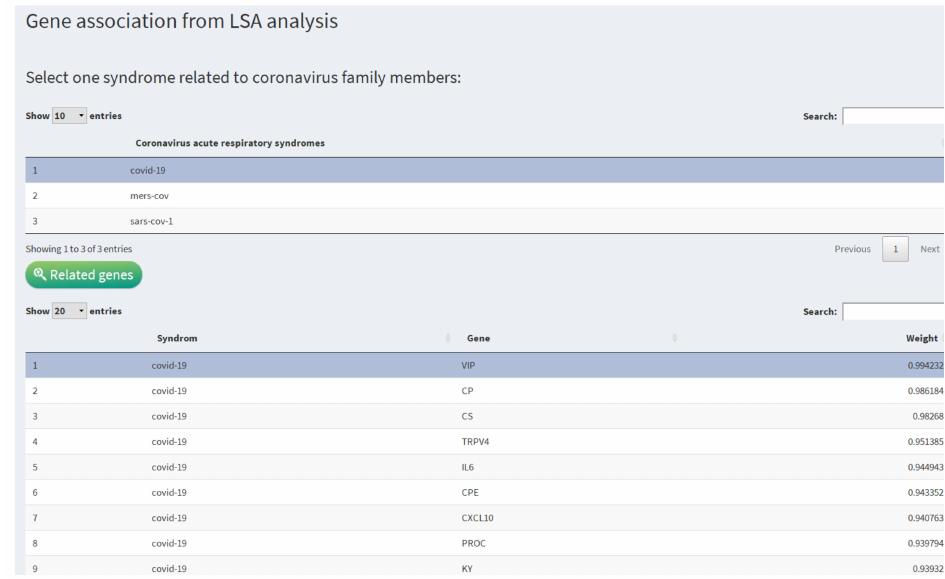
Figure 5. Association of genes with coronavirus diseases according to latent semantics